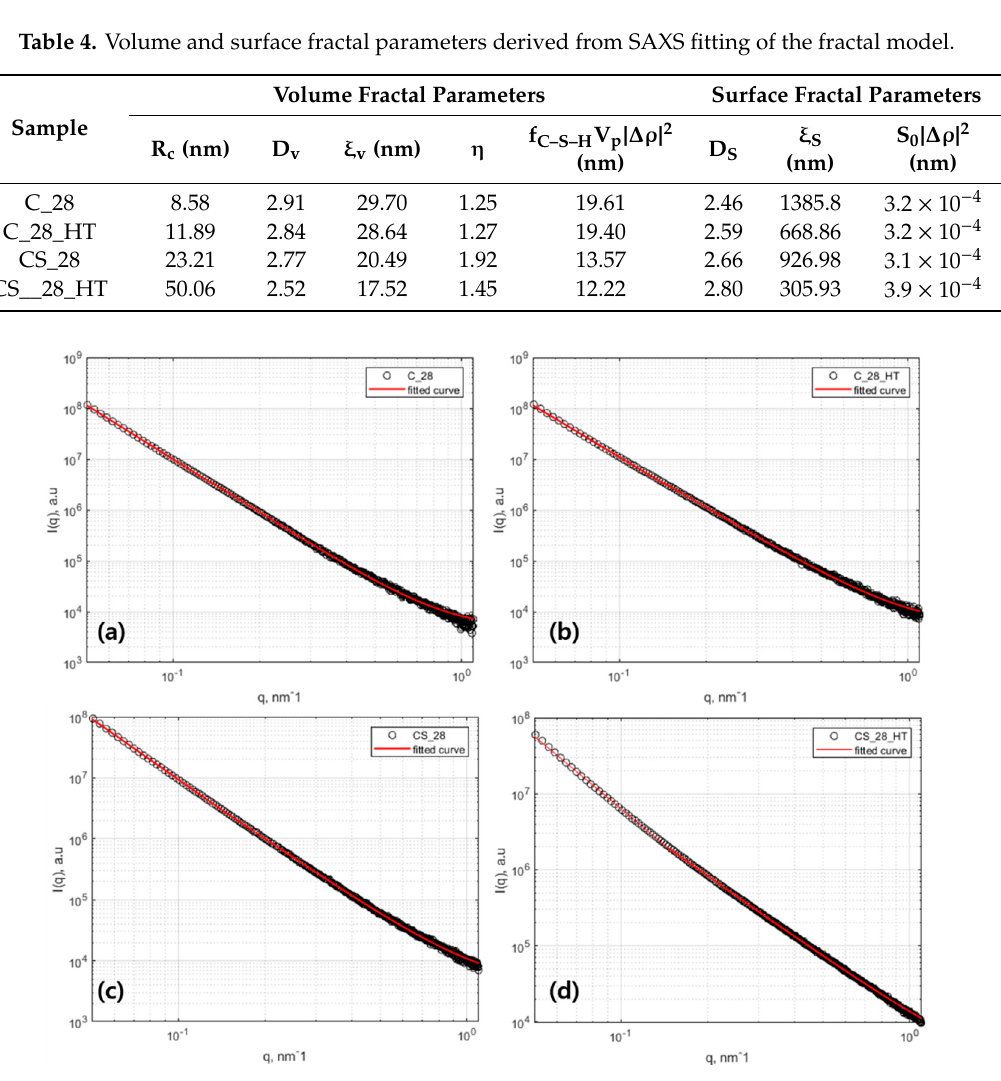
Figure 7. Small-angle X-ray scattering ( SAXS) fitting results: ( a ) C_28, ( b ) C_HT_28 ( c ) CS_28, and ( d ) CS_HT_28.